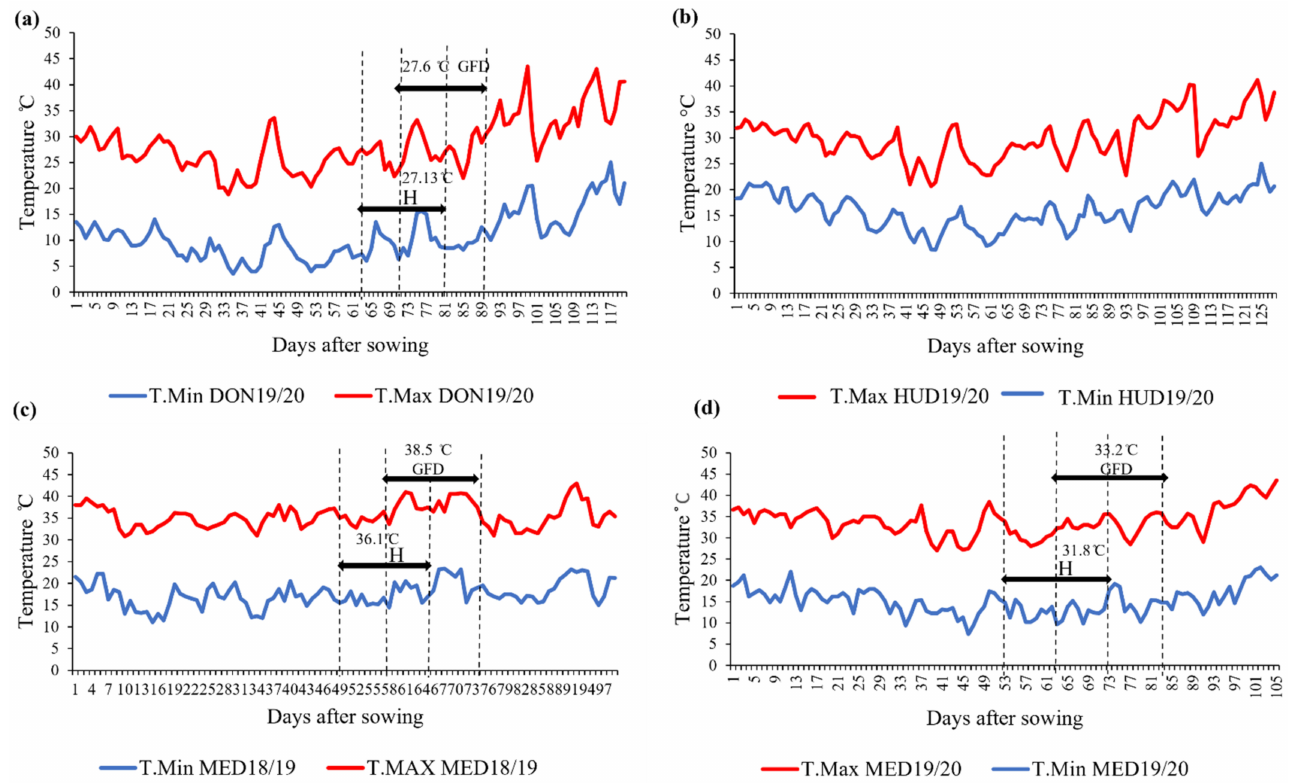
Figure 1. Daily maximum and minimum temperatures (T.Max and T.Min, respectively) during the wheat-cropping season at ( a ) DON19/20, ( b ) HUD19/20, ( c ) MED18/19, and ( d ) MED19/20. H: heading stage; GFD: grain-filling duration. The average maximum temperatures during the heading and grain-filling stages are shown at each location, except for HUD19/20 (no